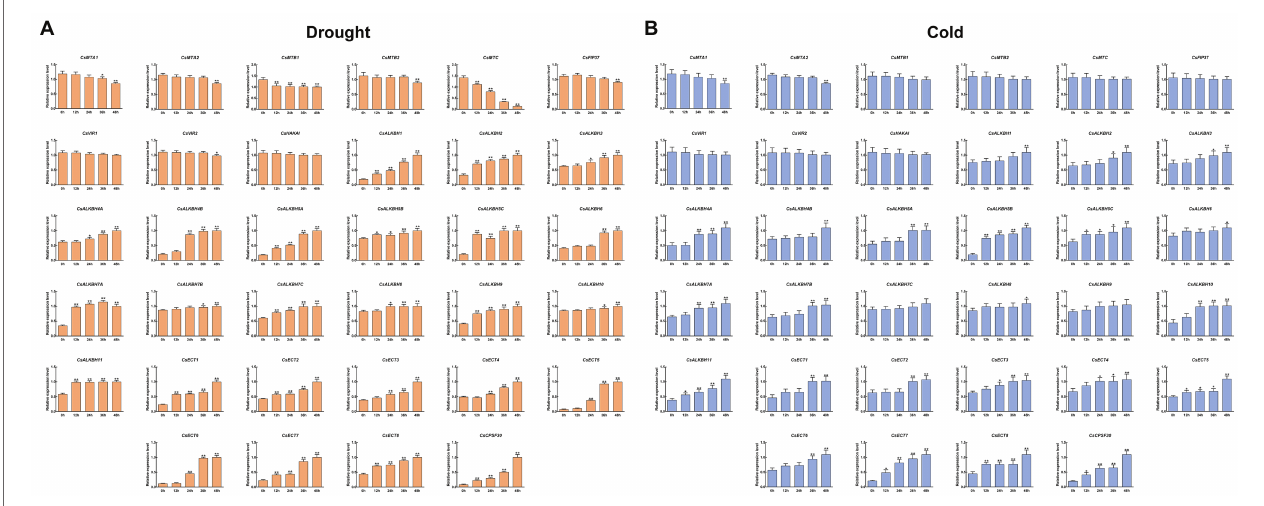
FIGURE 9 | Expression patterns of m6A regulatory genes under abiotic stresses determined by qRT-PCR. (A) Drought stress; (B) Cold stress. Data are presented as mean ± SD. Single asterisk indicates significant difference ( p < 0.05); double asterisks indicate highly significant difference ( p < 0.01). The stress treatment was performed on the healthy two-year-old tea plants ( C. sinensis cv. Tieguanyin) at the development stage of one bud with three leaves. To simulate drought treatment, tea leaves were sprayed with 15% (w/v) PEG-4000 solution. For cold treatment, the tea plants were transferred to the artificial climatic chamber and the temperature was set to 4 ° C. Then, all the tender leaves from treated tea plants were sampled at 0, 12, 24, 36, and 48 h, respectively. Three independent biological replicates were conducted for each